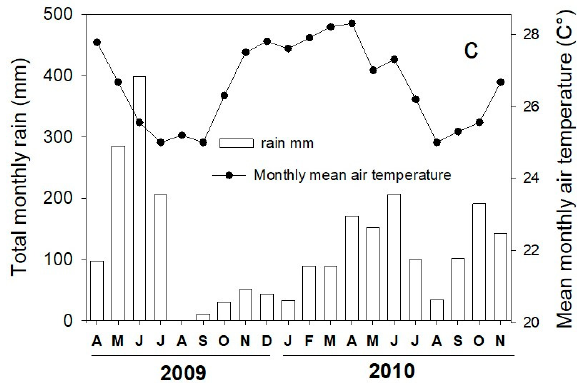
Figure 2. Total monthly rainfall (mm) and average mean monthly temperature estimated for the site from the TRMM database (Tropical Rainfall Measuring Mission, NASA).